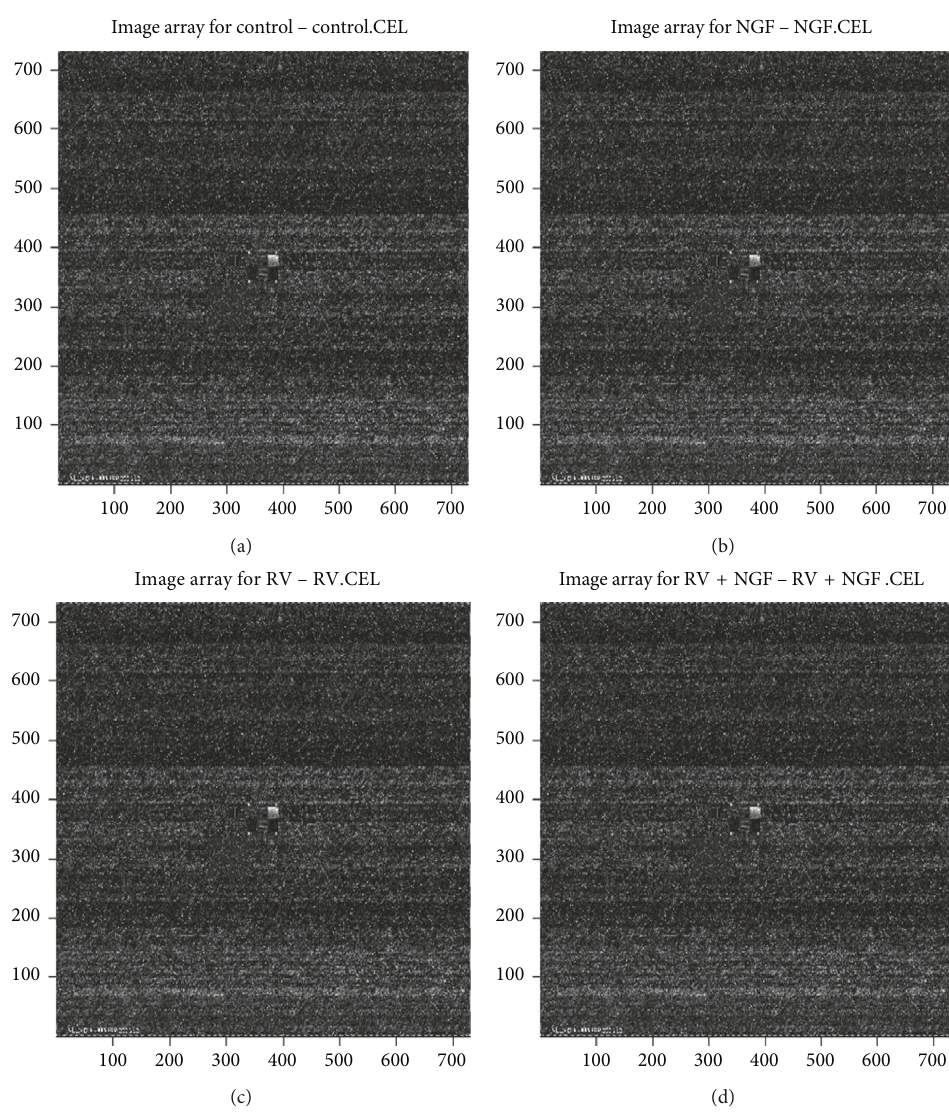
Figure 2: Affymetrix chip image: (a) control sample, (b) NGF sample, (c) RV sample, and (d) RV + NGF